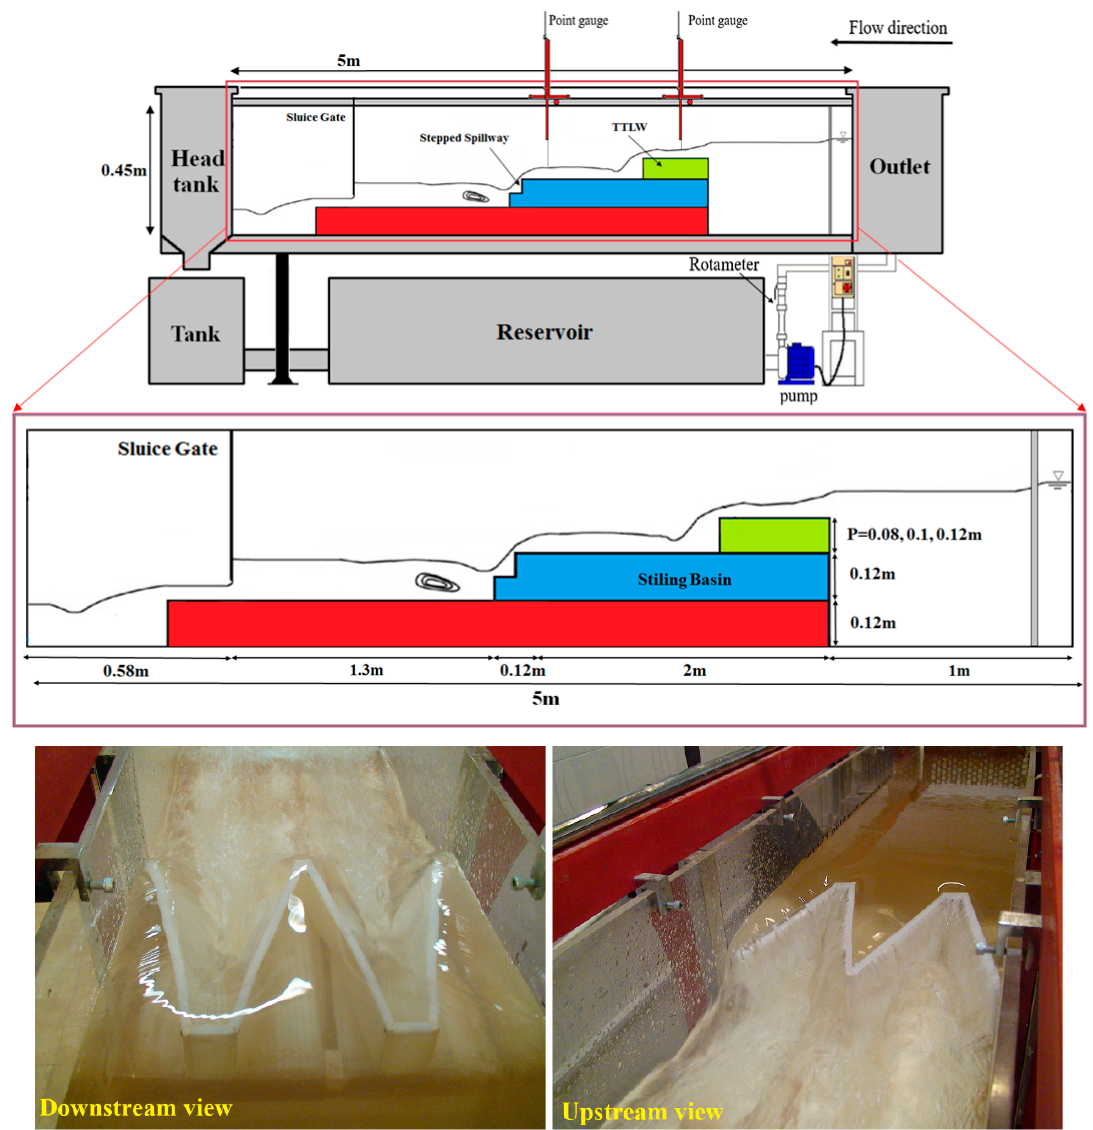
Figure 2. Schematic view of the test section and flumes.